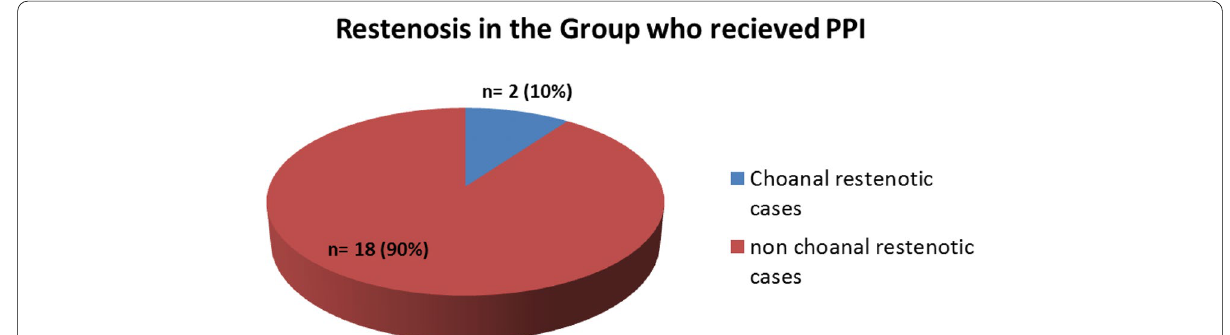
Fig. 1 Percentage of choanal restenosis among the group of cases who received PPI